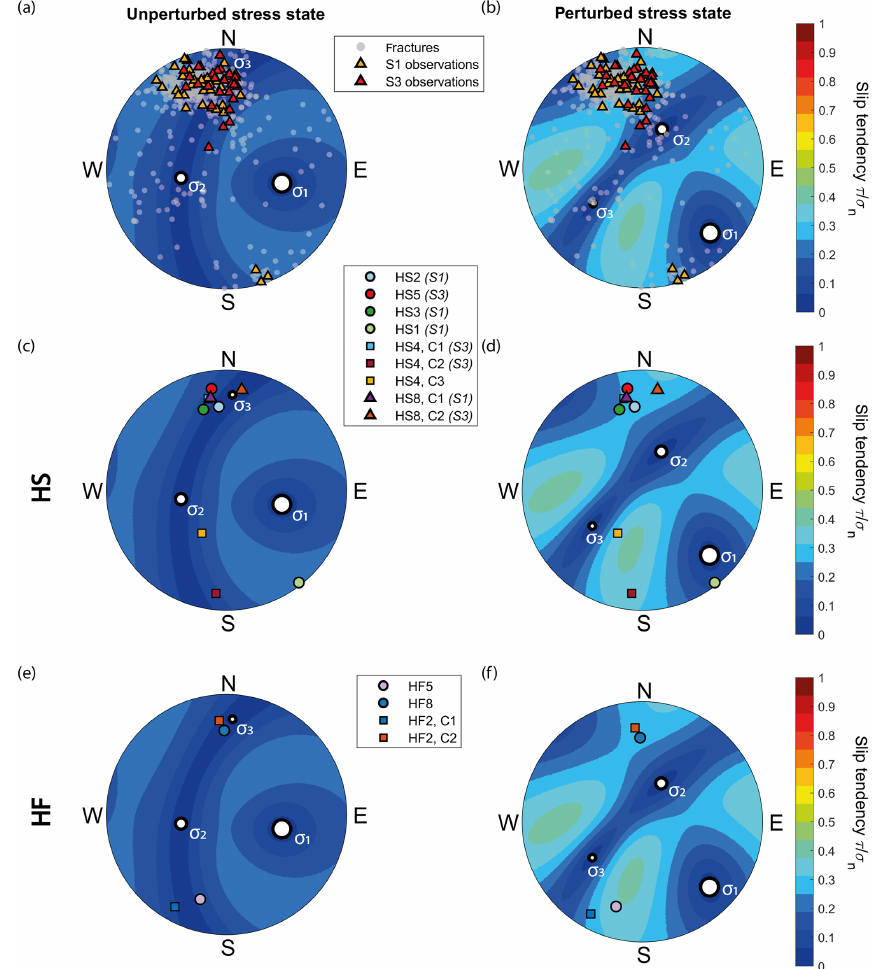
Figure 14. Principal stress directions of the unperturbed ( σ 1 = 13 . 1MPa, 104 ◦ dip direction/39 ◦ dip; σ 2 = 9 . 2MPa, 259 ◦ / 48 ◦ ; and σ 3 = 8 . 7MPa, 4 ◦ / 13 ◦ ) and perturbed stress state ( σ 1 = 13 . 1MPa, 134 ◦ dip direction/14 ◦ dip; σ 2 = 8 . 2MPa, 026 ◦ / 50 ◦ ; and σ 3 = 6 . 5MPa, 235 ◦ / 36 ◦ ) along with slip tendencies determined from the respective stress state in lower-hemisphere stereographic plots, along with (a, b) the fracture inventory from borehole observations, (c, d) pole points of seismicity cloud orientations of HS experiments, their tar- geted structures and (e, f) orientation of seismicity clouds of HF stimulation